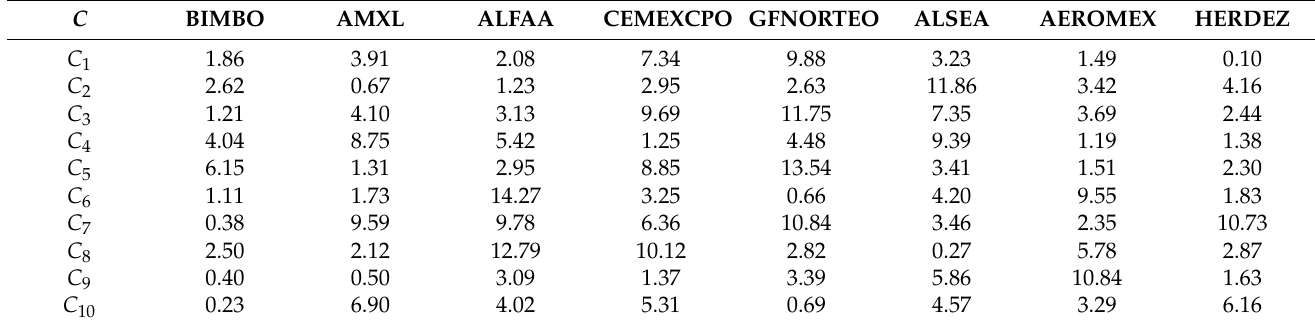
Table 3. Selected positive return periods to be